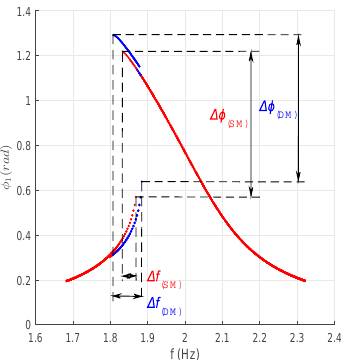
Figure 7. Example of measured amplitude and frequency ranges of the multistability domain according to the SM and DM.